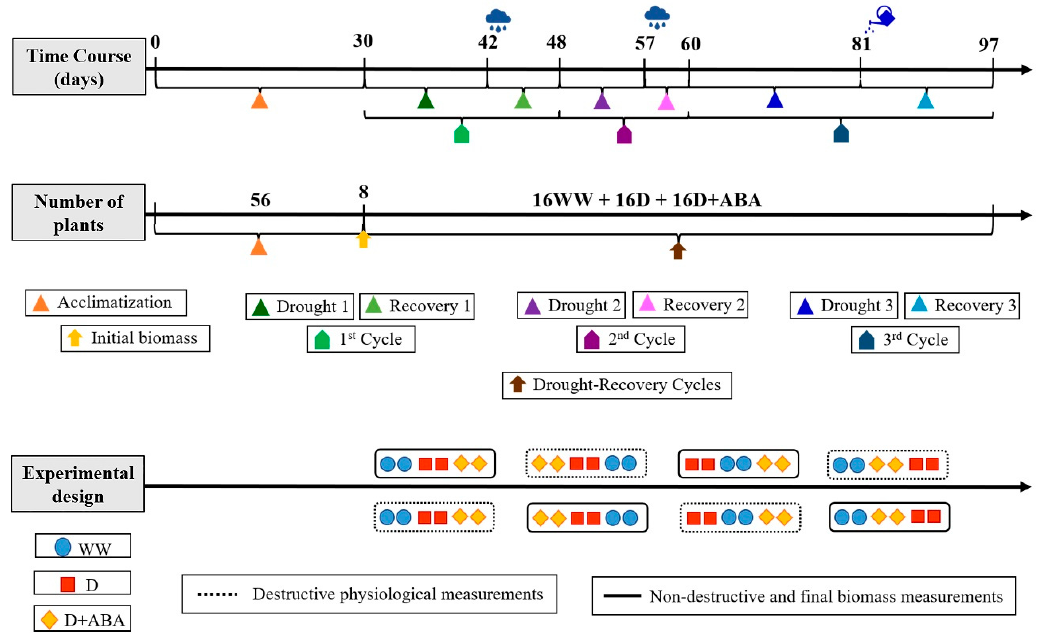
Figure 1. Schematization of the experiment. Well-watered (WW) and droughted without (D) and with abscisic acid (D + ABA) plants.